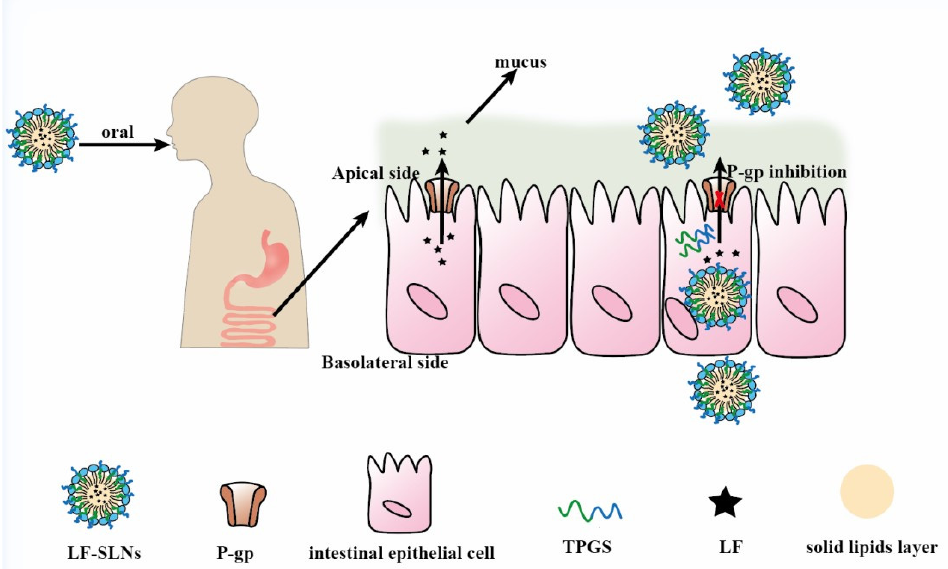
Figure 7. Mechanisms of LF-SLNs improving the oral bioavailability of LF. Remodified and sum- marized with permission from [103]. Copyright© 2016 Elsevier